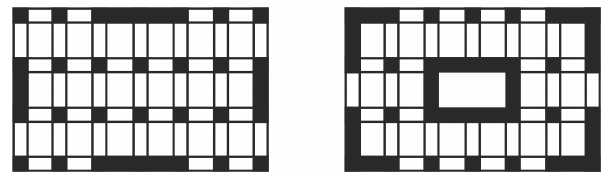
Figure 24. Suitable partition placements (Aktan and Kirac, 2010).